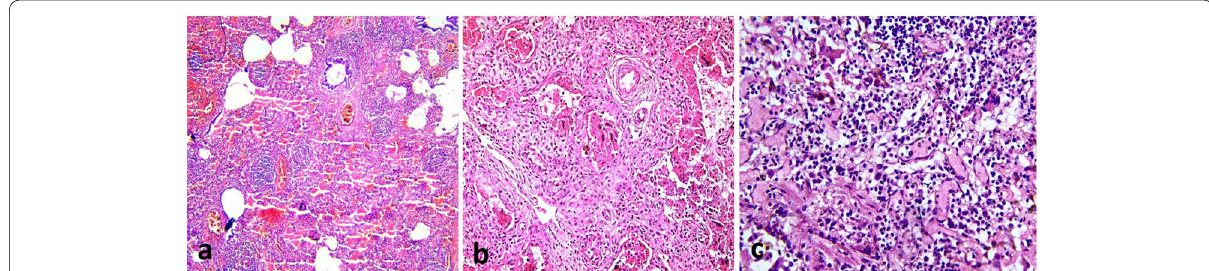
Fig. 2 Histopathological picture of viral pneumonia. a Pronounced and dense interstitial lymphomonocytic inflammatory infiltrate (H&E Interstitial mononuclear inflammatory infiltrate and giant cells in the alveolar lumina (H&E